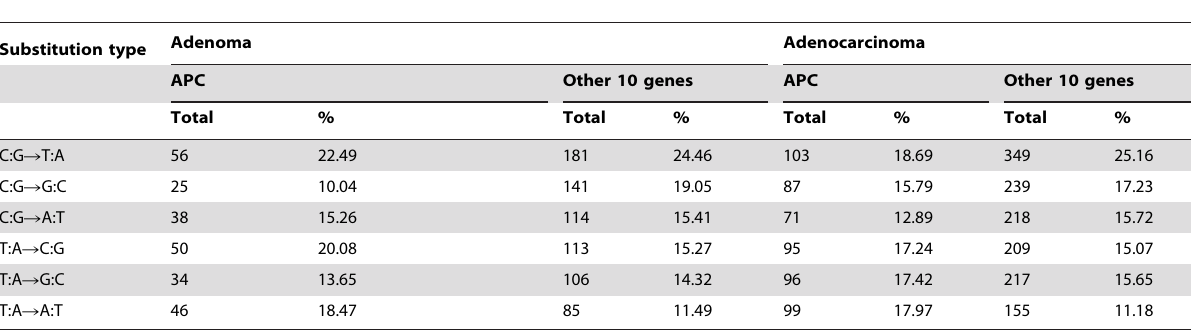
Table 3. Exonic base substitution types of APC and 10 other genes in canine colorectal tumors.*